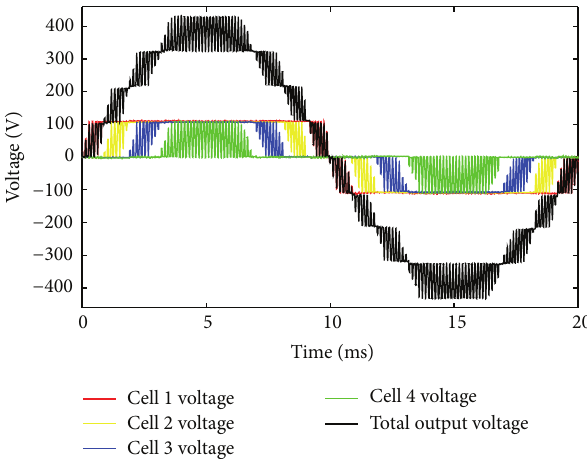
Figure 11: Cell voltages and the total output voltage of the 9-level